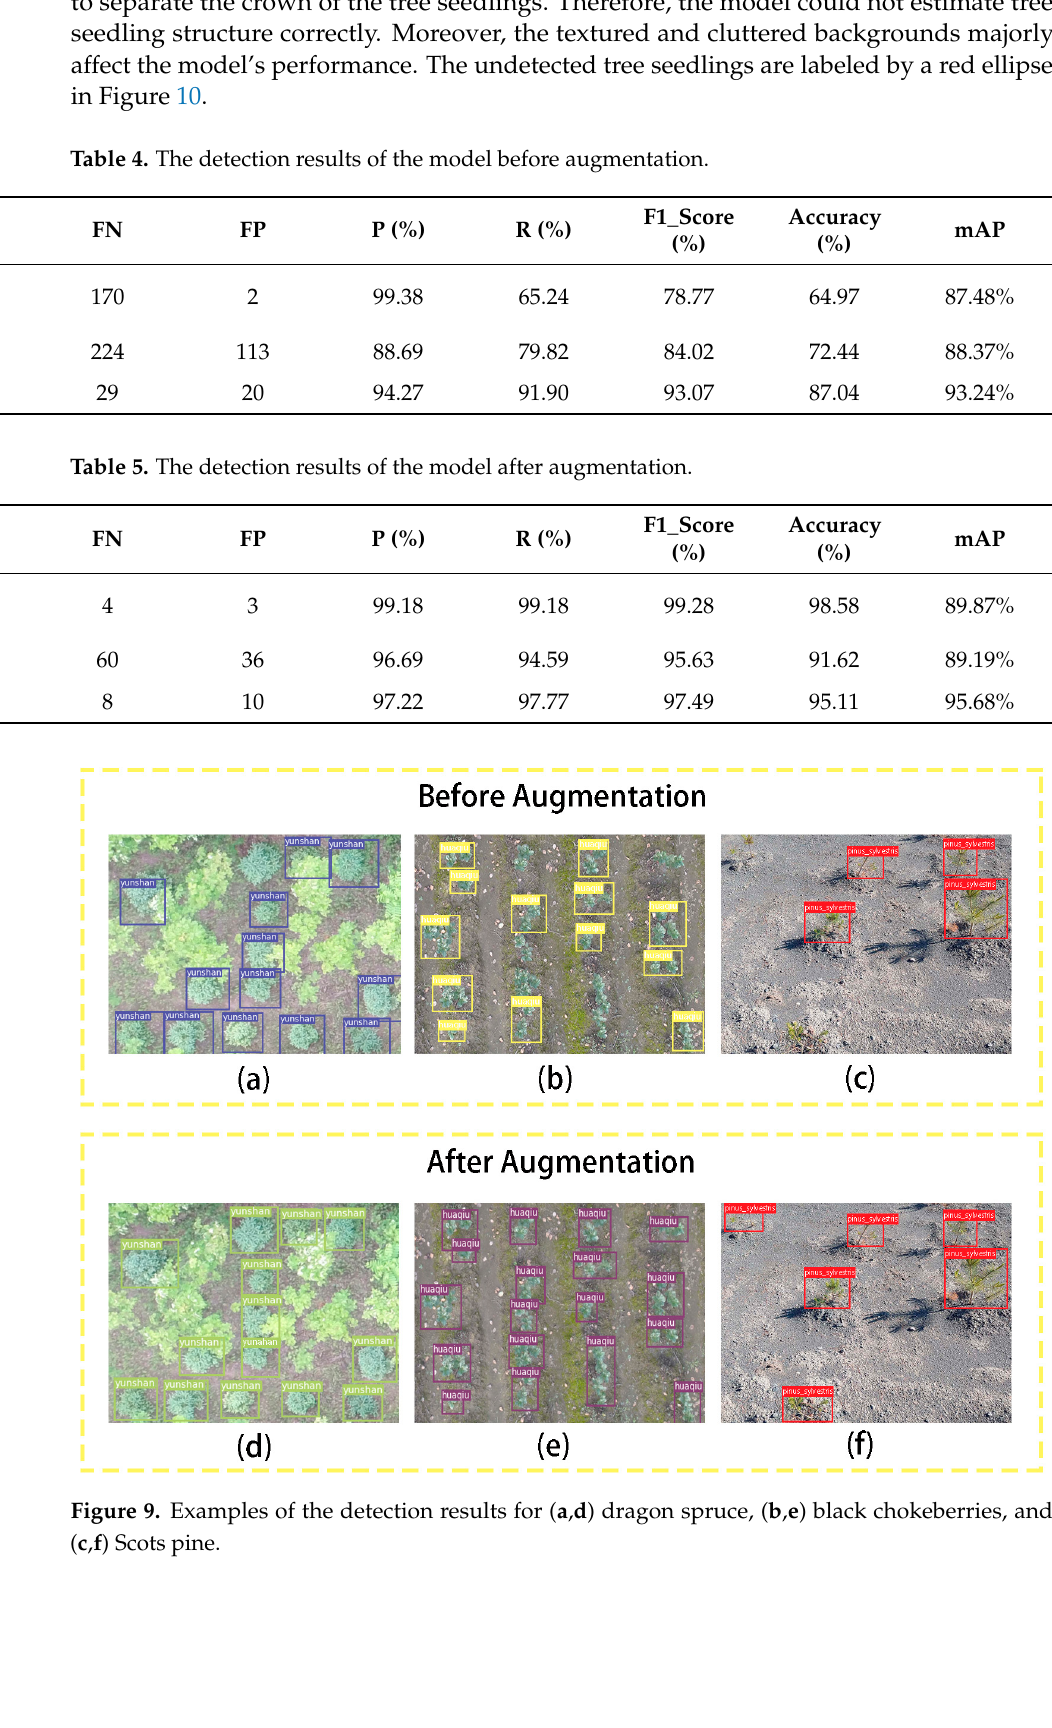
( b ) ( c ) Figure 10. Examples of the missed detection of tree seedlings for ( a ) dragon spruce, ( b ) black choke- berries, and ( c ) Scots pine.